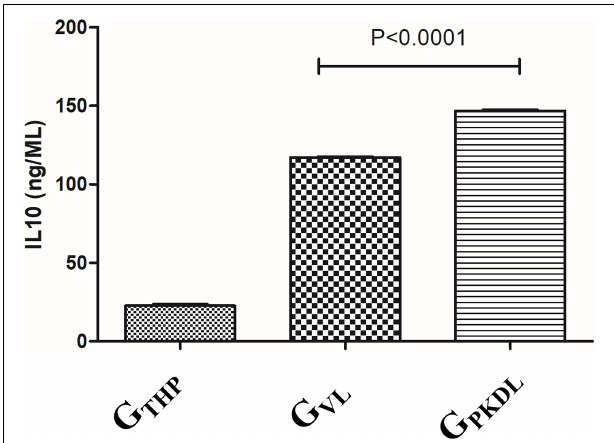
FIGURE 9 | THP cells (1 × 10 6 ) were uninfected and infected with 1 × 10 7 late log phase L. donovani promastigotes (1:10) isolates from visceral leishmaniasis (VL) patients for 12 h. In another set, THP cells were infected with 1 × 10 7 late log phase L. donovani promastigotes (1:10) isolates from post-kala-azar dermal leishmaniasis (PKDL) patients for 12 h. Results are represented as mean ± SD for three independent